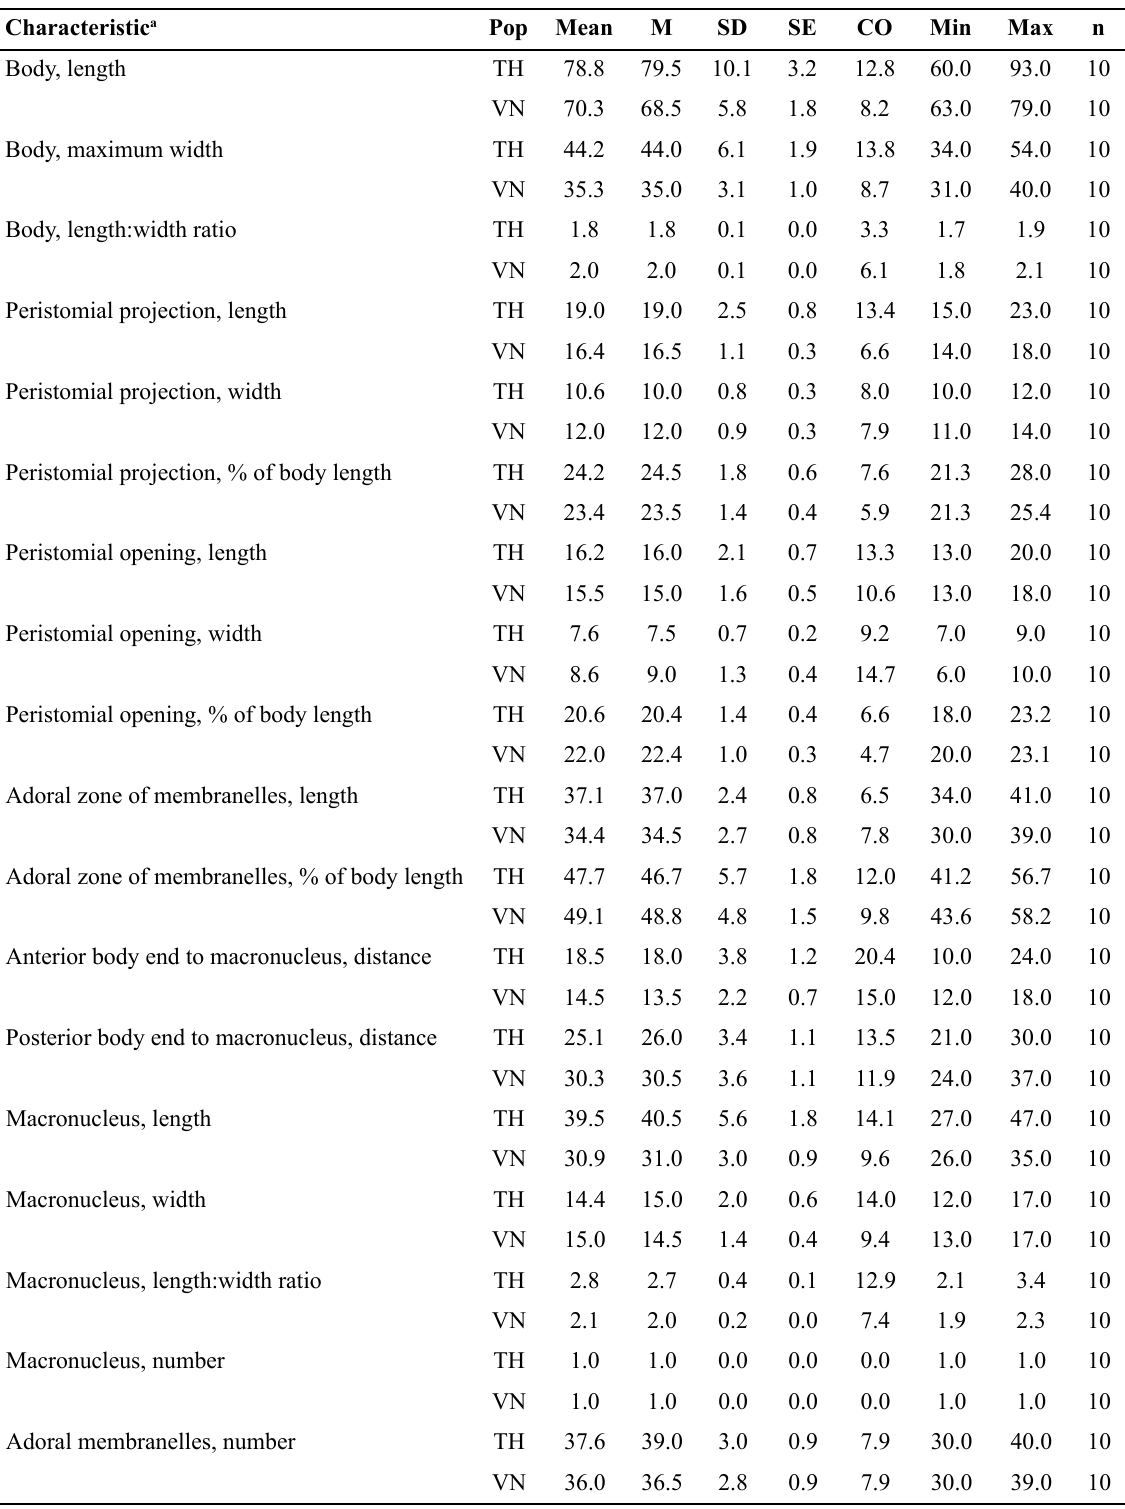
Table 4. Morphometric data on Clevelandella parapanesthiae (Kidder, 1937) from Thailand and